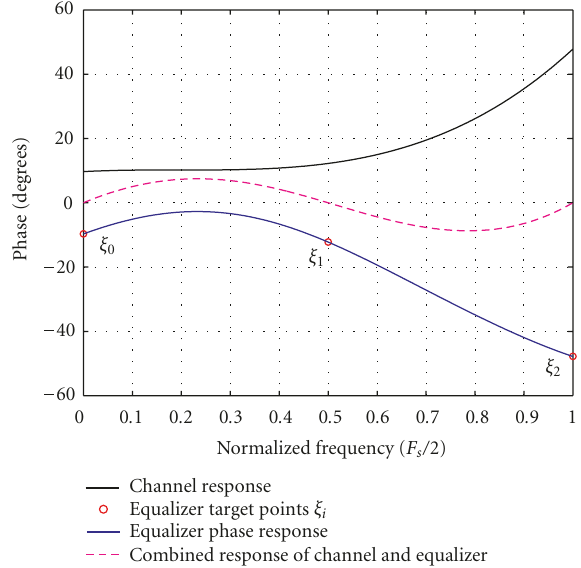
Figure 7: Operation of the Case 3 phase equalizer